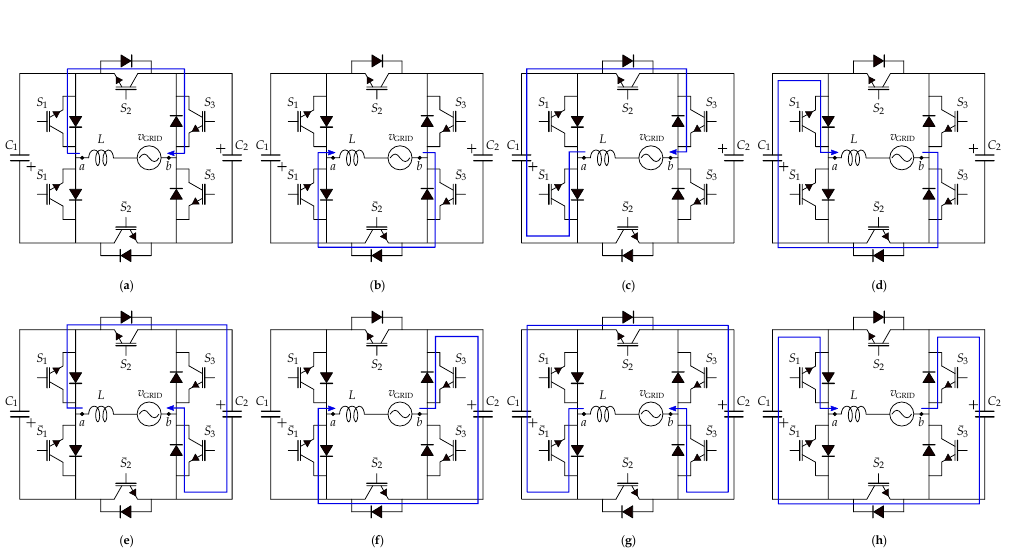
Figure 2. Operating and conduction modes of cross-connected half-bridges multilevel inverter ( CCHB - MLI ): ( a ) Mode 1: 0 V DC . ( b ) Mode 2: 0 V DC . ( c ) Mode 3: V DC . ( d ) Mode 4: − V DC . ( e ) Mode 5: V DC . ( f ) Mode 6: − V DC . ( g ) Mode 7: 2 V DC . ( h ) Mode 8: − 2 V DC